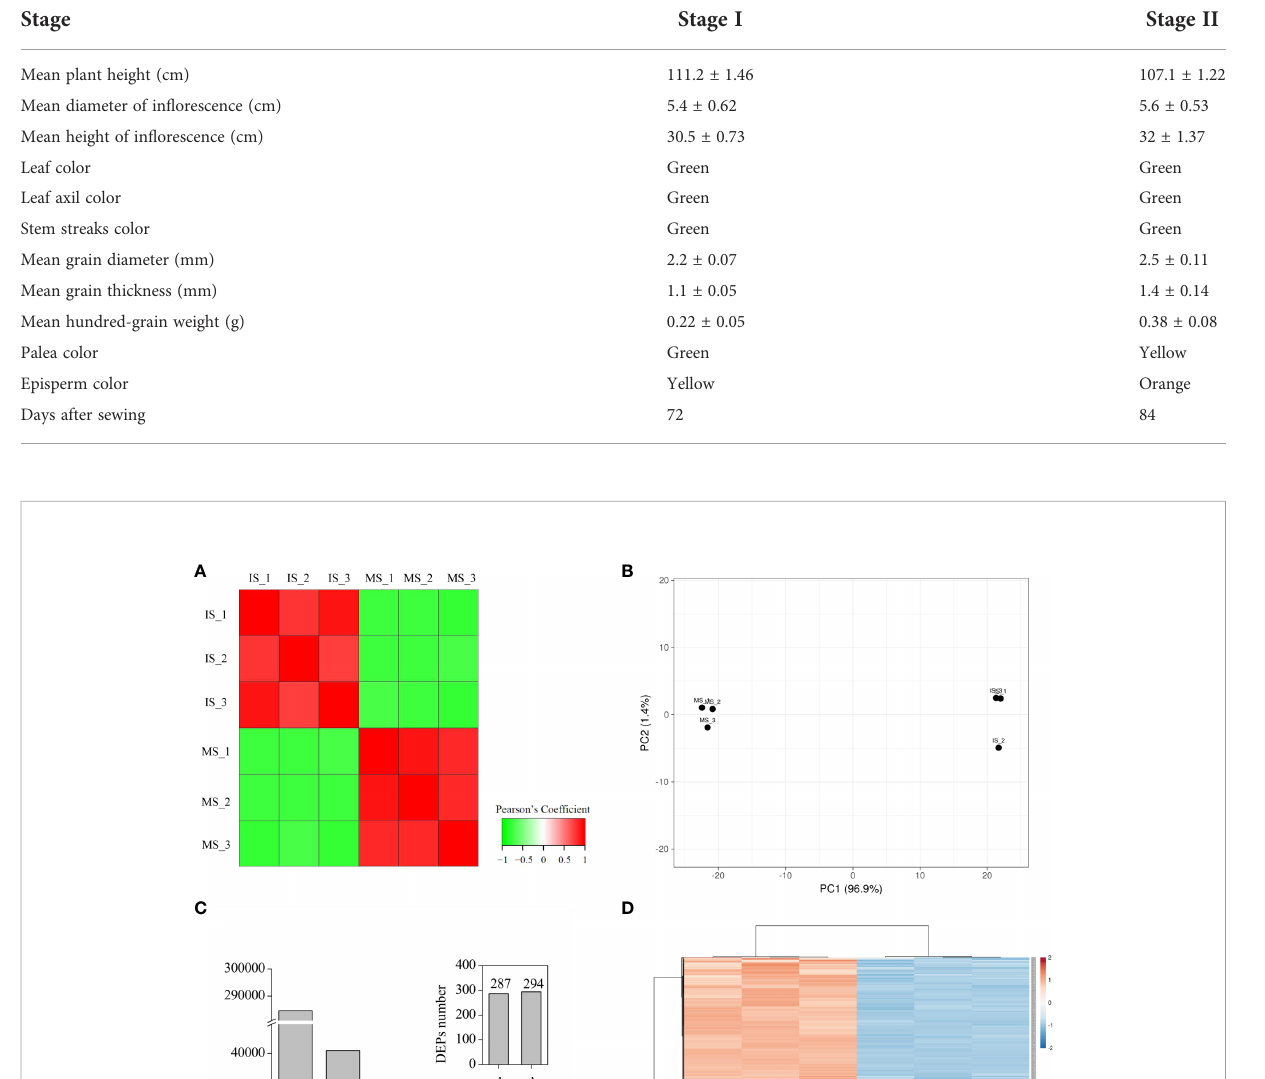
TABLE 1 Morphological characteristics of the plant in two development